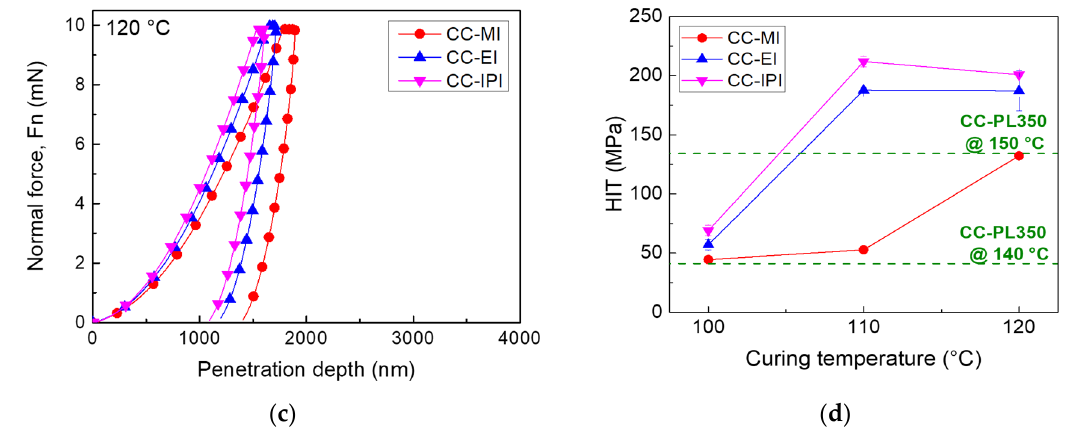
Figure 5. Normal force vs. penetration depth curves of cured thin clearcoat films with imidazole-BIs at ( a ) 100 °C, ( b ) 110 °C, and ( c ) 120 °C. ( d ) Surface hardness (HIT) values of cured clearcoat films evaluated from normal force-penetration depth curves of ( a – c ).